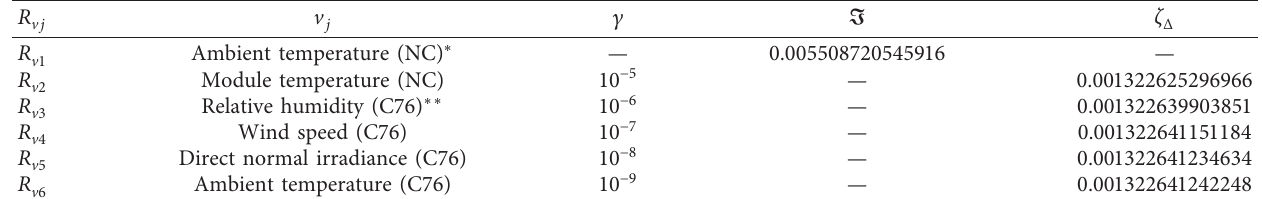
for 3kWp PV power Δ